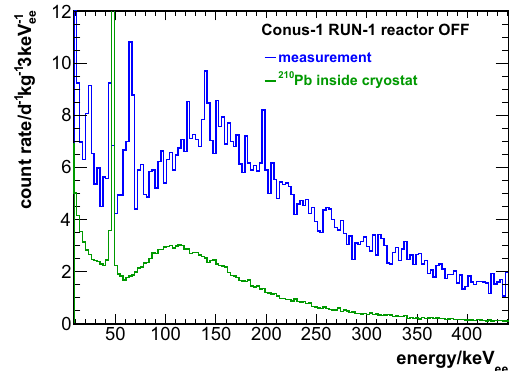
Fig. 16 MC simulation of 210 Pb decays within the innermost Pb layer of the CONUS shield registered by C1, scaled with the respective mea- sured activities of the Pb bricks. It becomes evident that the contam- ination within the bricks adjoined to the detector is the most